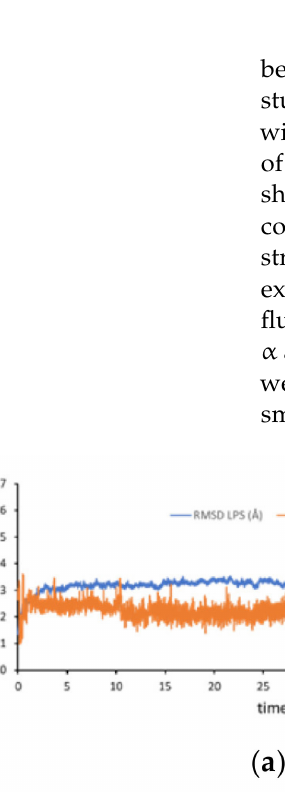
Figure 8. RMSD values relative to the starting structure along 50 ns of MD simulation of PSL complexed to ( a ) α -rhamnose and ( b ) β - rhamnose. The Y axis shows the RMSD values in Å and the X axis the time in nanoseconds. RMSD values are represented in blue for the lipase and orange for